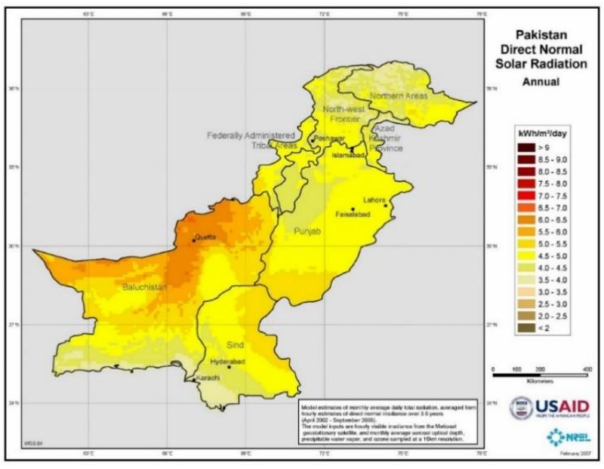
Figure 1. Solar map of Pakistan